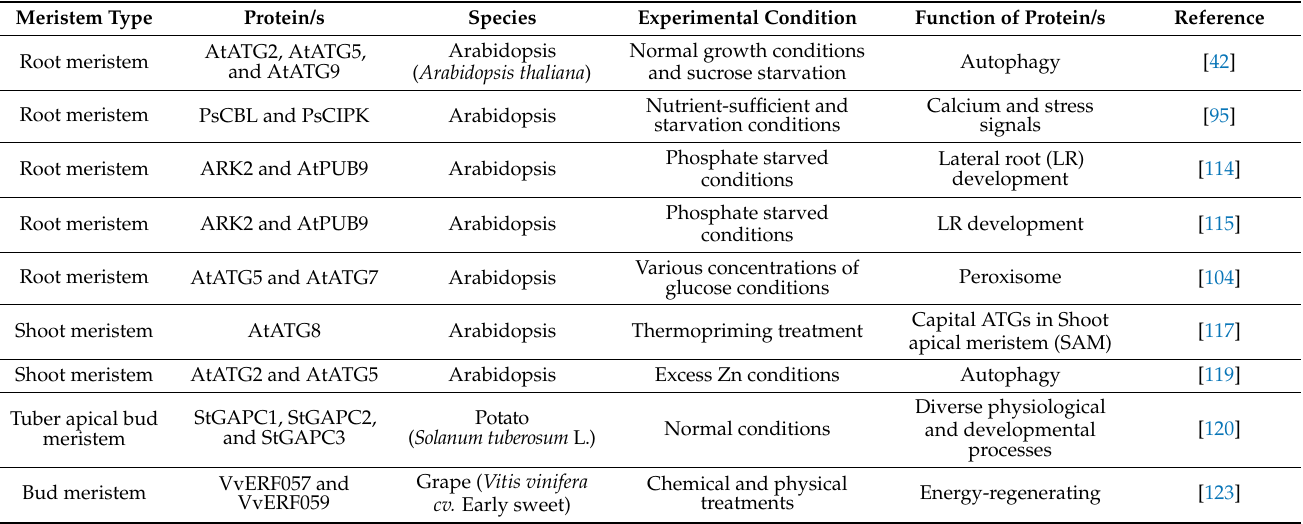
Table 1. Autophagy-linked proteins in plant